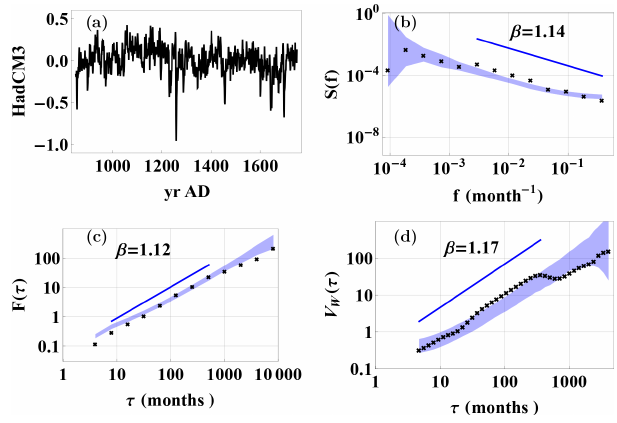
Figure 12. (a) The temperature from the HadCM3 experiment. (b) PSD, (c) DFA2, and (d) WVA2 applied to the record. The shaded areas show the 95% confidence range for synthetic fGn with β esti- mated by PSD, DFA2 and WVA2. The β -values are estimated from the slopes of the straight lines and the range of scales used for es- timation is indicated by the length and position of these line seg- ments. The estimated β -values are indicated in the